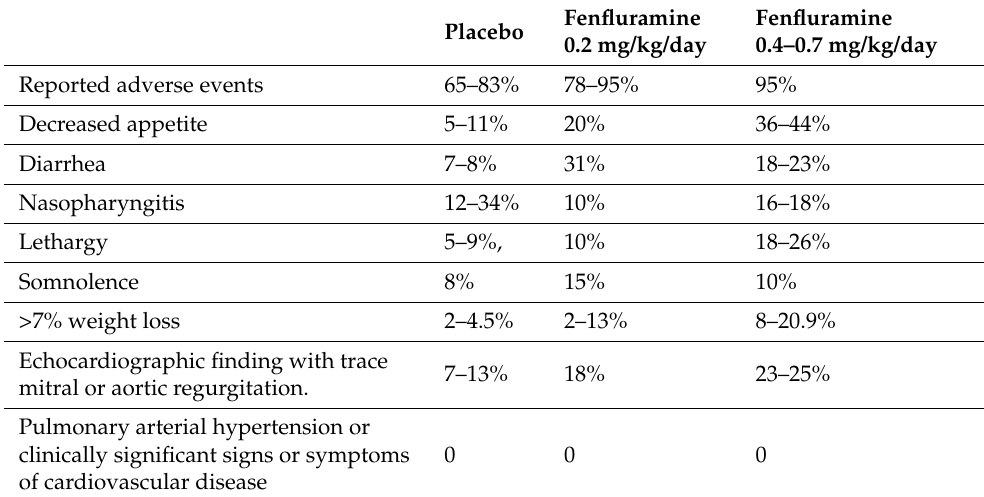
Table 1. Reported adverse events of fenfluramine and placebo groups in randomized controlled